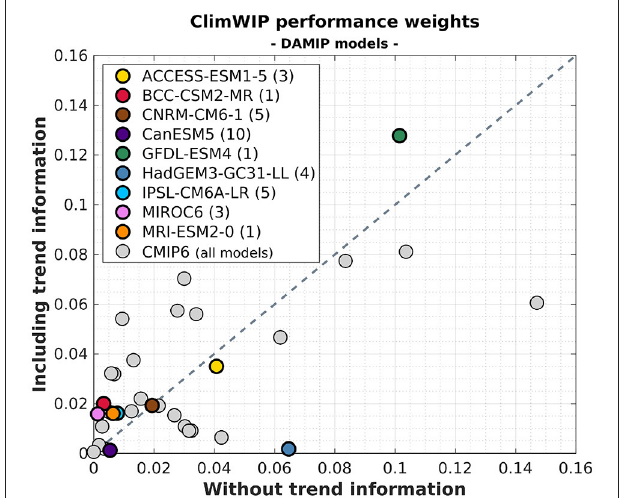
FIGURE 3 | Role of temperature trends in model performance weights, illustrating the relationship between the model-specific relative weights assigned by ClimWIP, computed using global fields excluding temperature trend information (along the x-axis), and including a temperature trend metric (along the y-axis). Climate models across CMIP6 are shown in gray; those also available in the DAMIP simulations (used in the ASK method) have been colored, with the number of ensemble members (n) shown in the